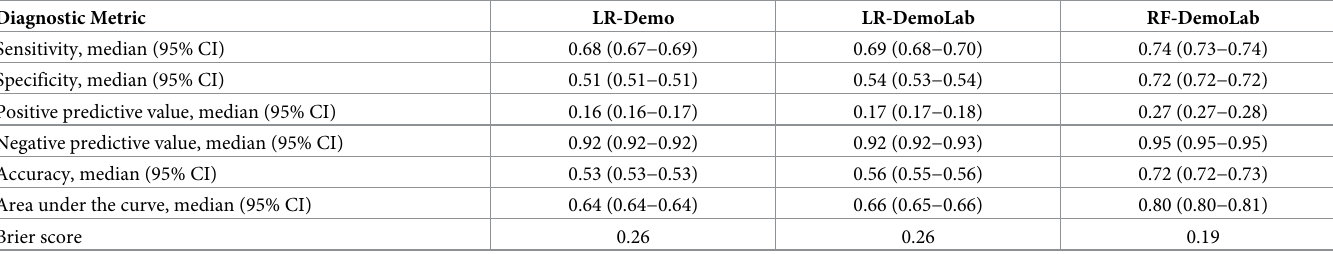
Table 2. Bootstrapped estimates of median and 95% confidence interval (CI) model performance